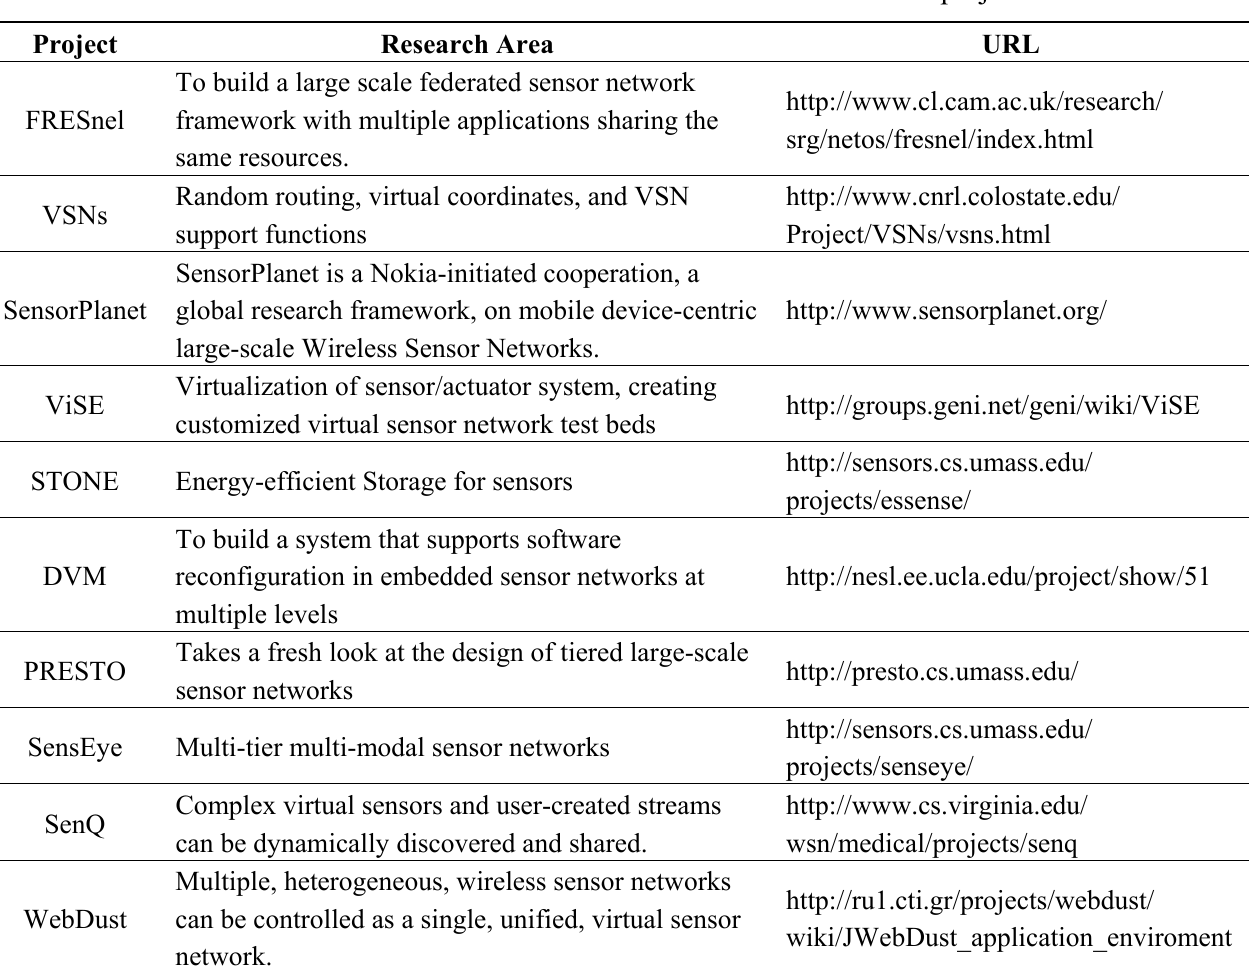
Table 1. Sensor network virtualization researches in different